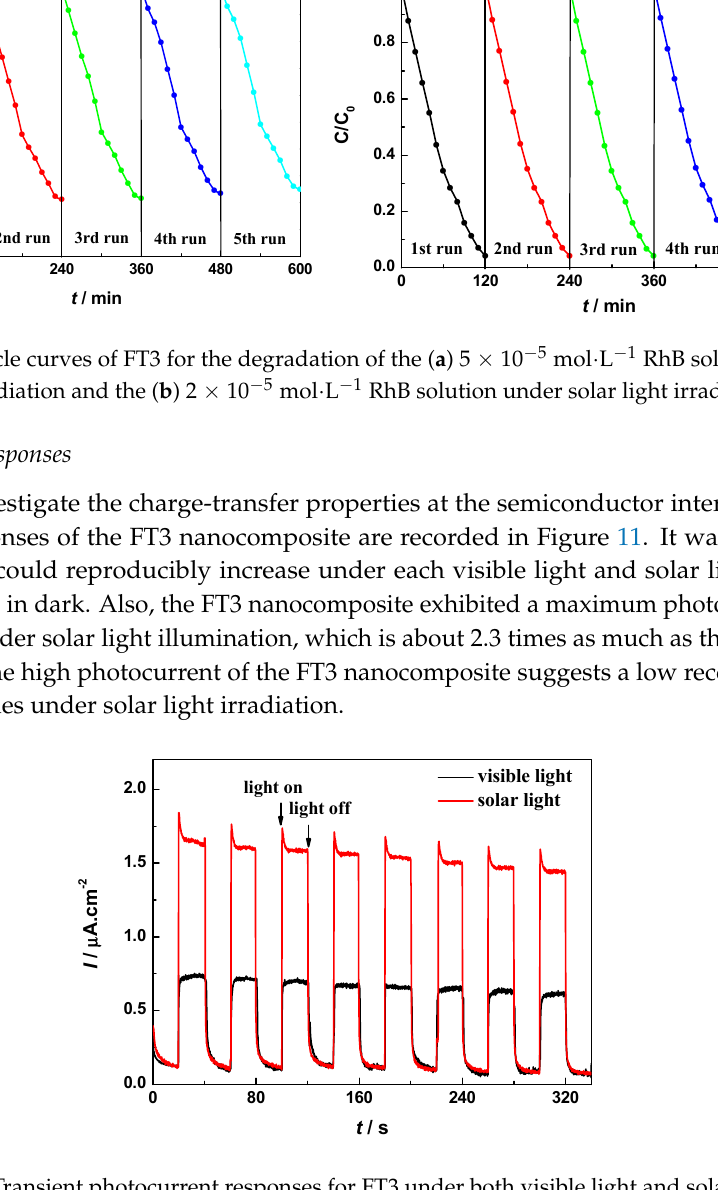
Figure 11. Transient photocurrent responses for FT3 under both visible light and solar light.